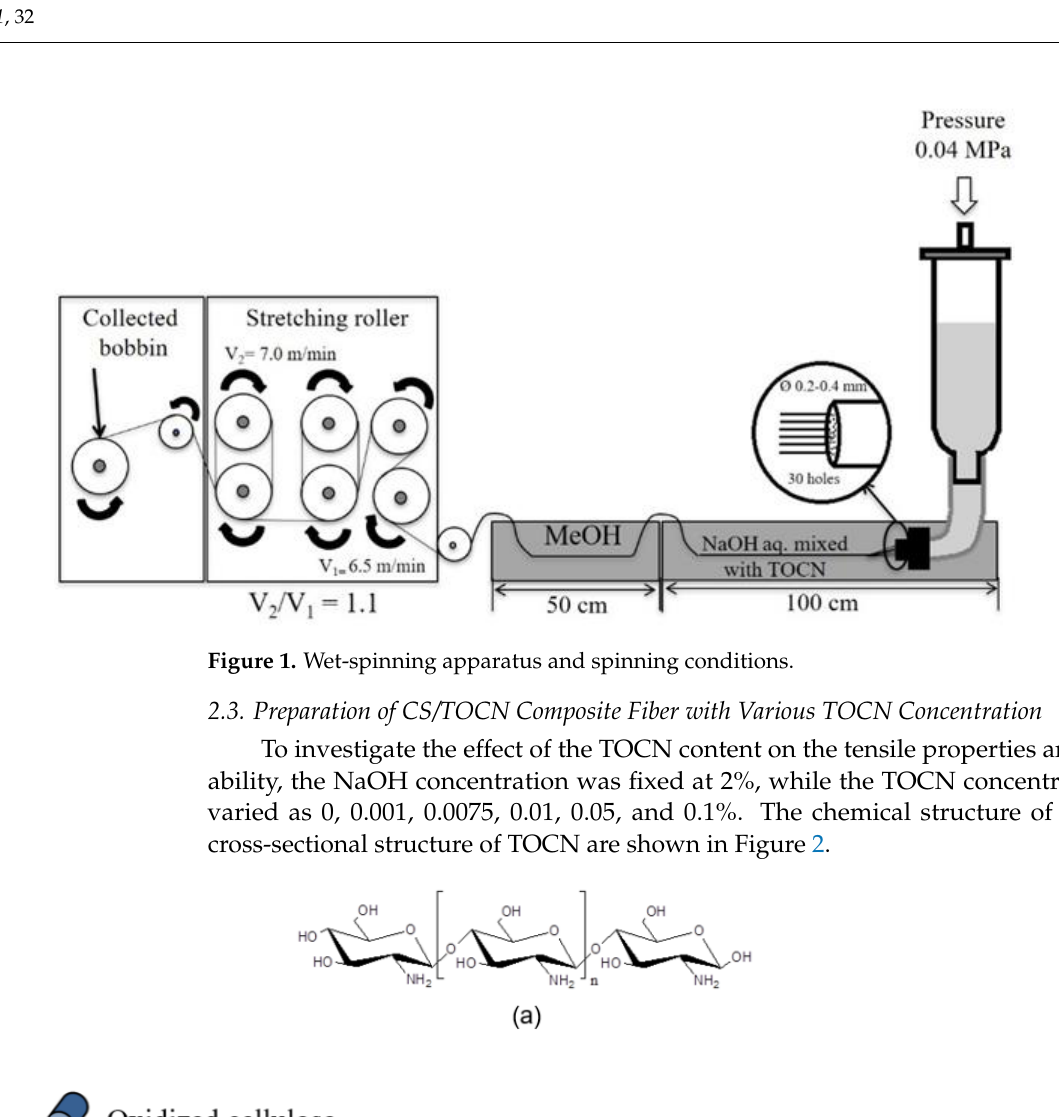
Figure 2. ( a ) Chemical structure of CS; ( b ) cross-sectional structure of TOCN.